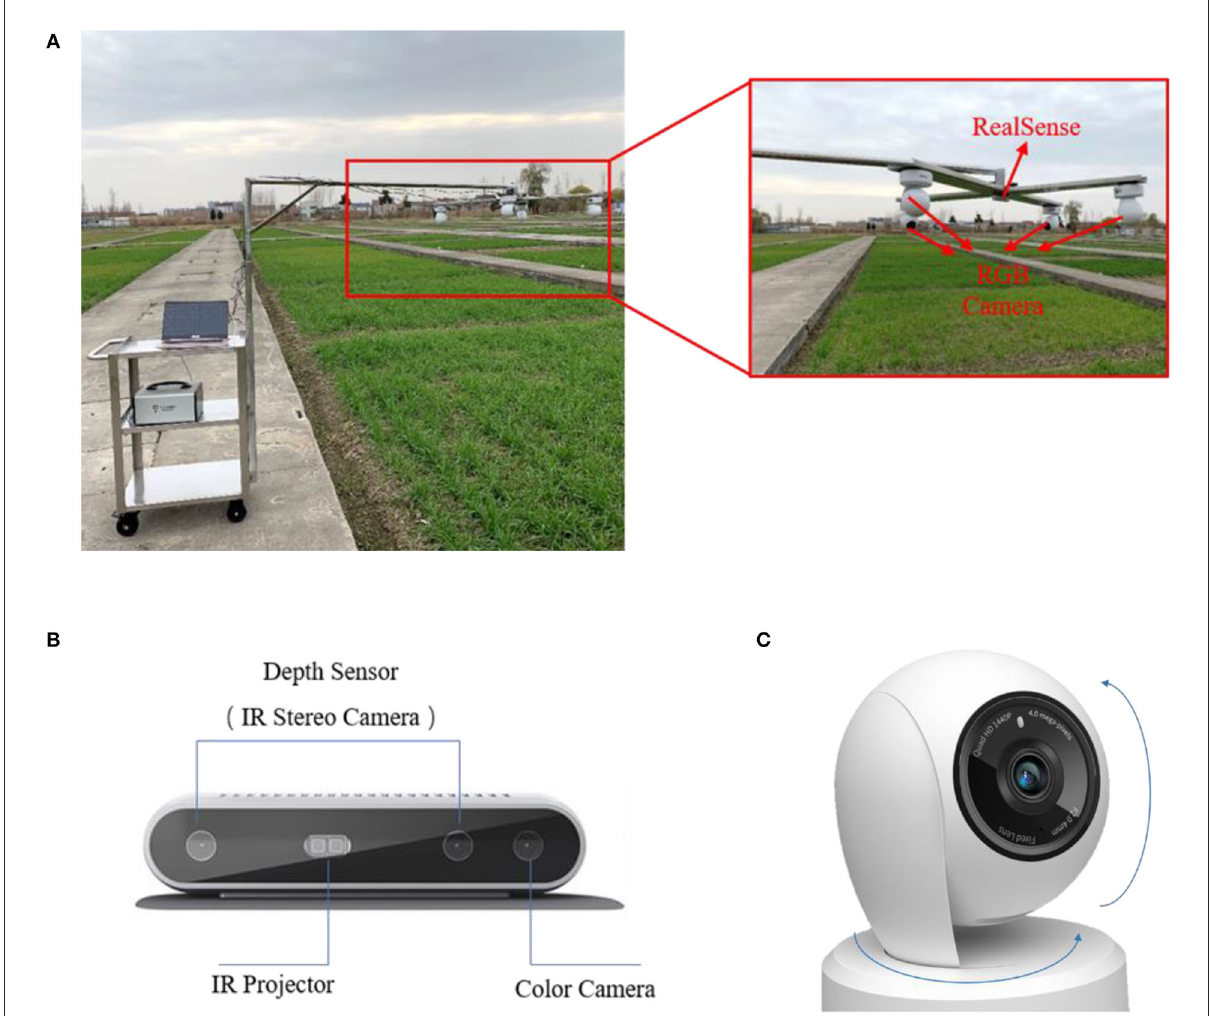
RGB and depth field images under natural